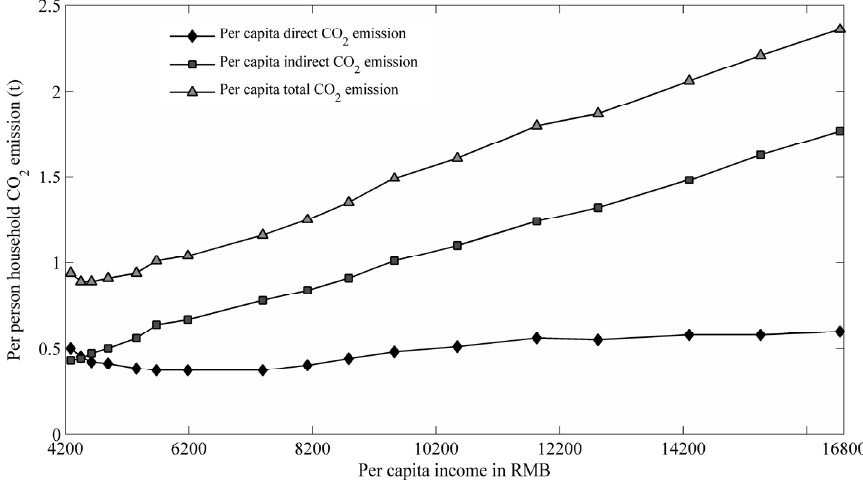
Figure 2. Relationship between per capita incomes ( PCIs ) (constant price for year 2000) and direct, indirect, and total per person HCEs in urban